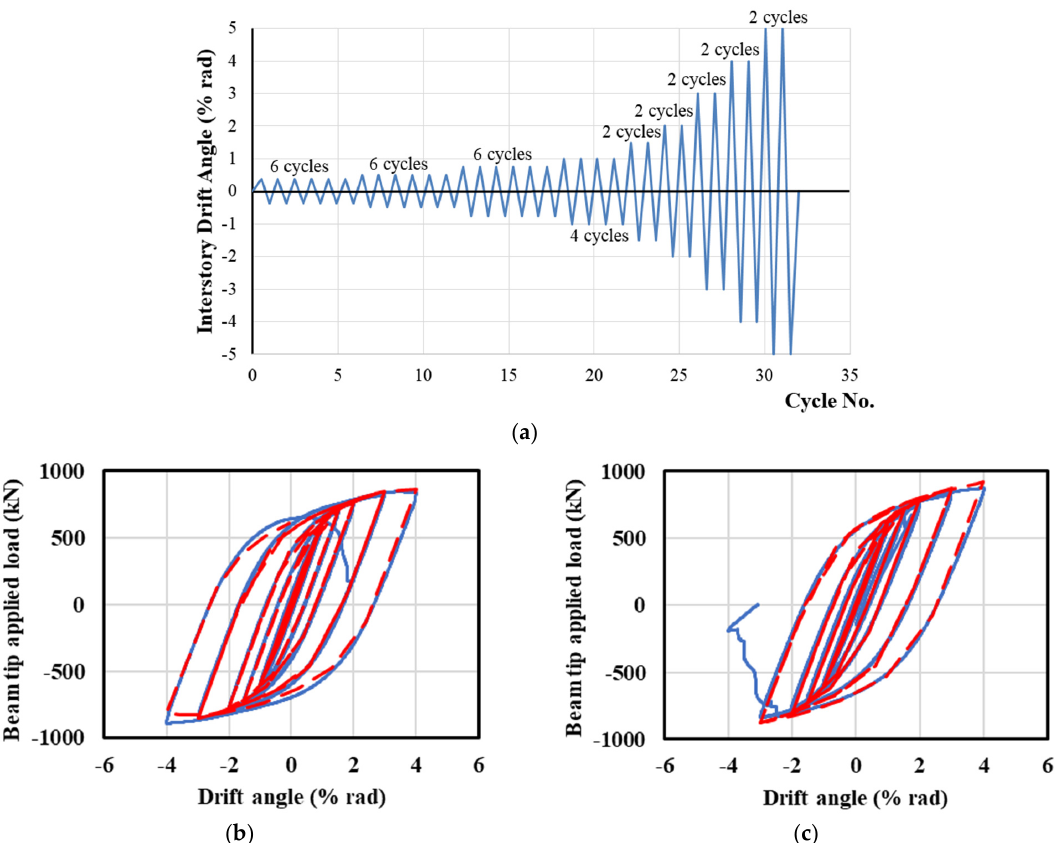
Figure 3. Loading protocol and simulation of connection tests: ( a ) AISC loading protocol, ( b ) UR-connection, ( c ) DS-connection (simulation in red and test in blue).